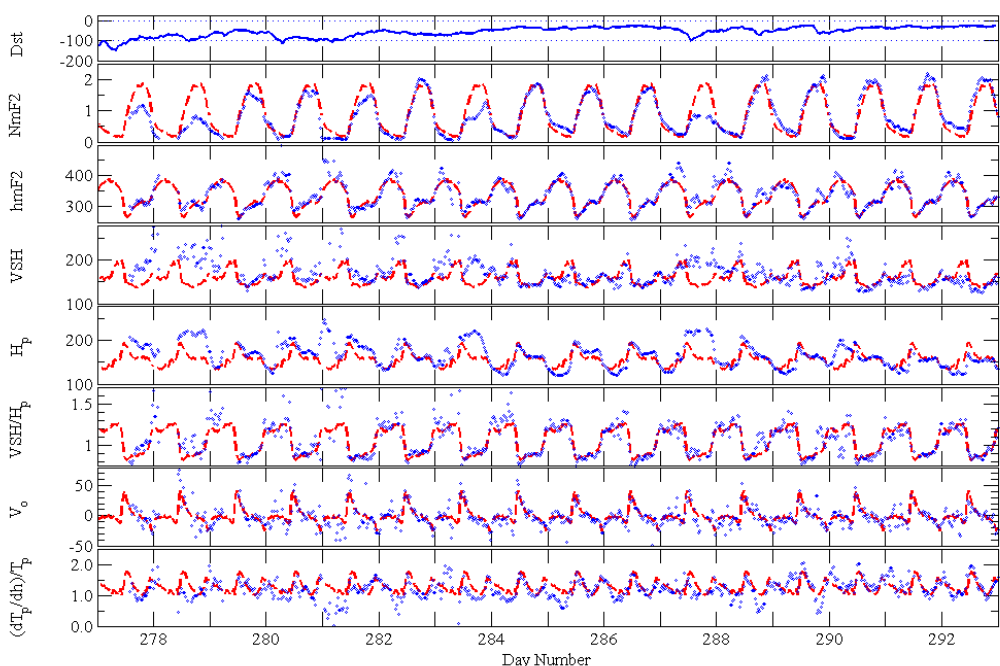
Fig. 5. Geomagnetic index D st and N m F 2 , h m F 2 , VSH, H p , VSH/ H p , V o , and (d T p /dh)/ T p derived from the Millstone Hill ISR experiment during 4 October to 20 October 2002. The dashed curves show the median values, and points for half-hourly averaged values. Here V o represents values around 500km in units of m/s, N m F 2 is in units of 10 12 m − 3 , and h m F 2 , VSH and H p in